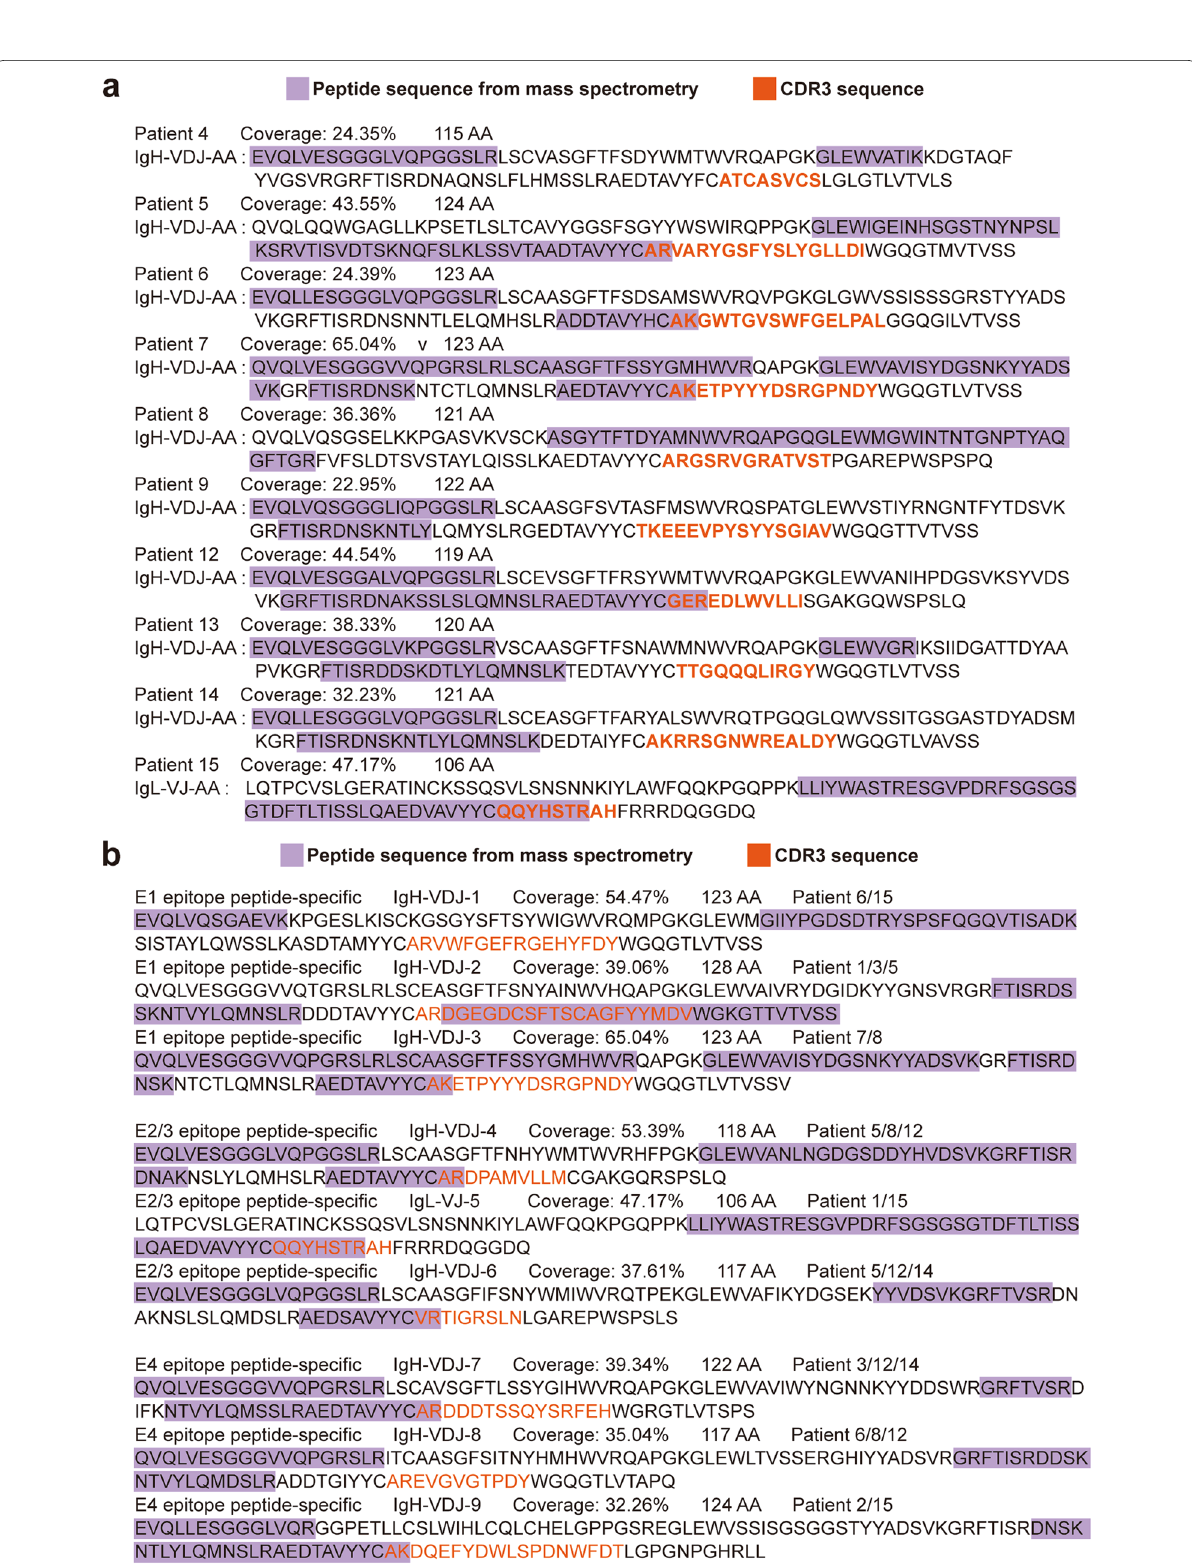
Fig. 5 Match the mass spectrometry sequence with the sequencing sequence. a The mass spectrometry sequences were matched with the sequencing sequence from the same patient. The highly matched sequences that only exist in only one of the patients were shown. b The highly matched sequences that exist in different patients were